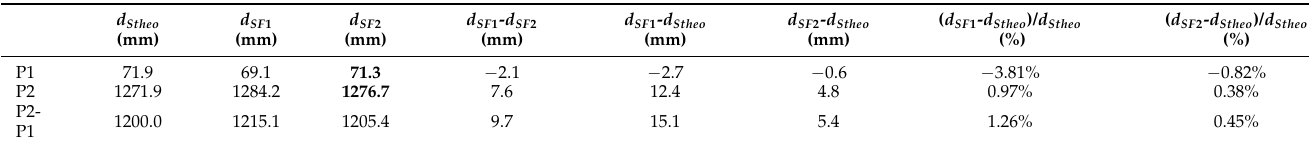
Table 3. Comparison of the theoretical values and the fitted distances d S based on the function SwingF 1 and SwingF 2 for both pivot axis P1 and P2 as well as the distance between P1 and P2.